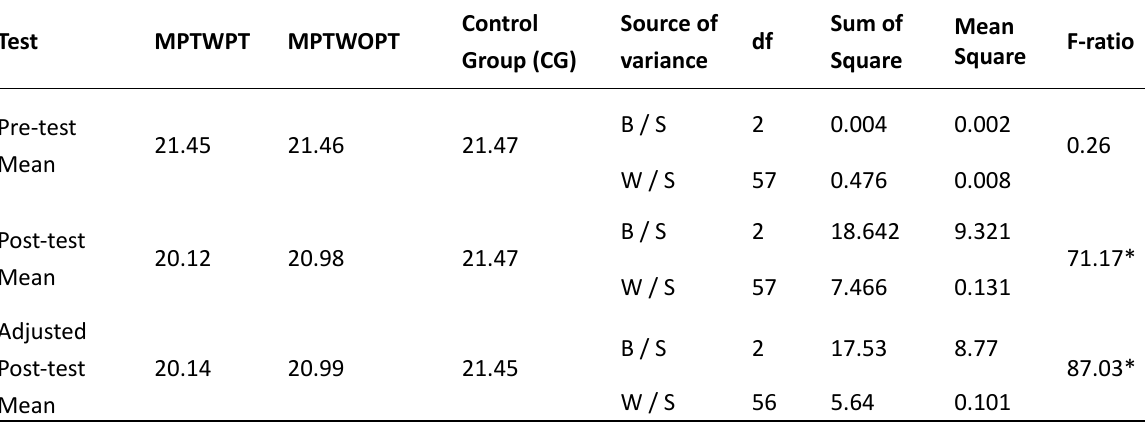
Table 2. Analysis of covariance on Pre, Post and Adjusted Posttest means on speed endurance of MPTWPT, MPTWOPT and Control Group (Scores in